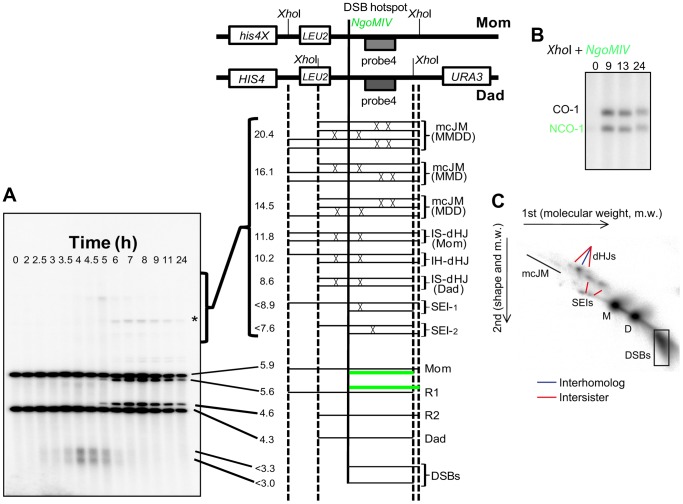
Assessment of meiotic recombination at the HIS4LEU2 hotspot.(A–C) The HIS4LEU2 hotspot. mcJM: multichromatid joint molecules (abbreviations: M-Mom, D-Dad), IS-dHJ intersister double Holliday Junctions, IH-dHJ interhomolog double Holliday Junctions, SEI- single-end invasions, DSBs- double strand breaks. Digesting with XhoI gives diagnostic band sizes from parental molecules, Mom and Dad, as well as recombinant fragment lengths (R1 and R2). These are predominantly crossovers. The different molecules can be separated on 1D (A) and shape-dependent separation on 2D gels (C). Further digestion with NgoMIV differentiates noncrossovers from parental molecules (B). The * indicates a non-specific signal.